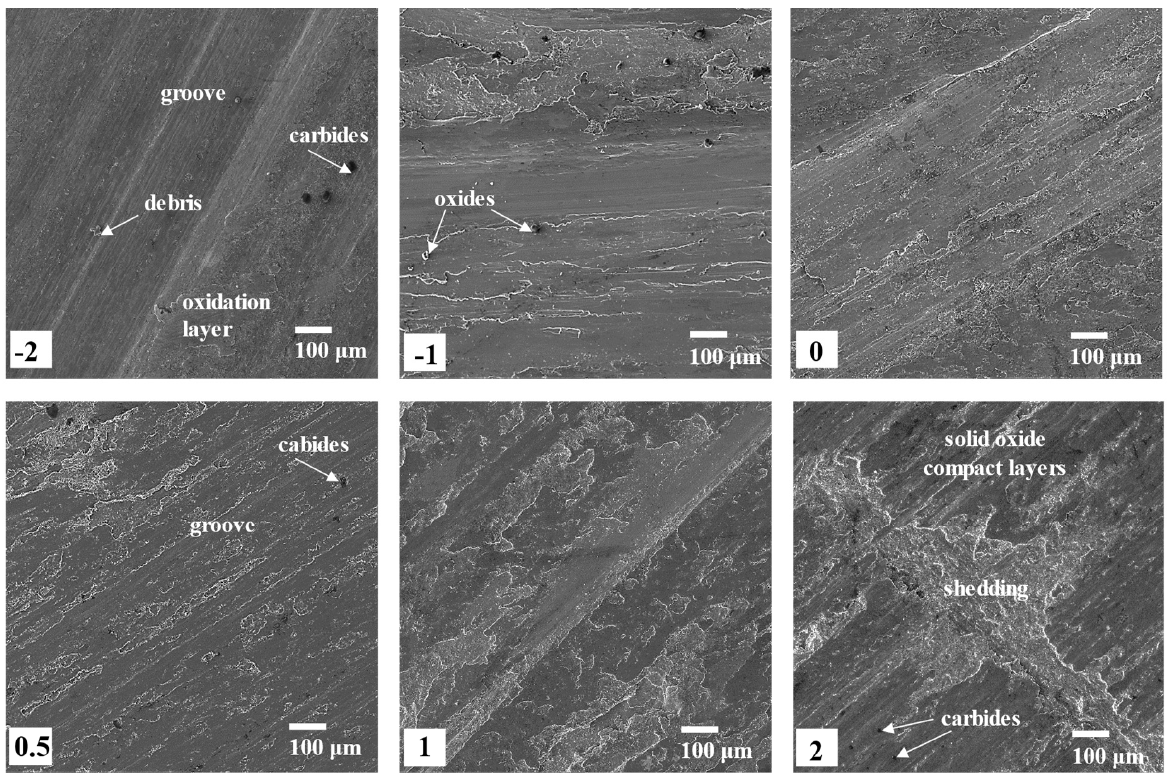
Figure 10. Worn surface morphology of the six series samples shown in Figure 3 (after 90 min).